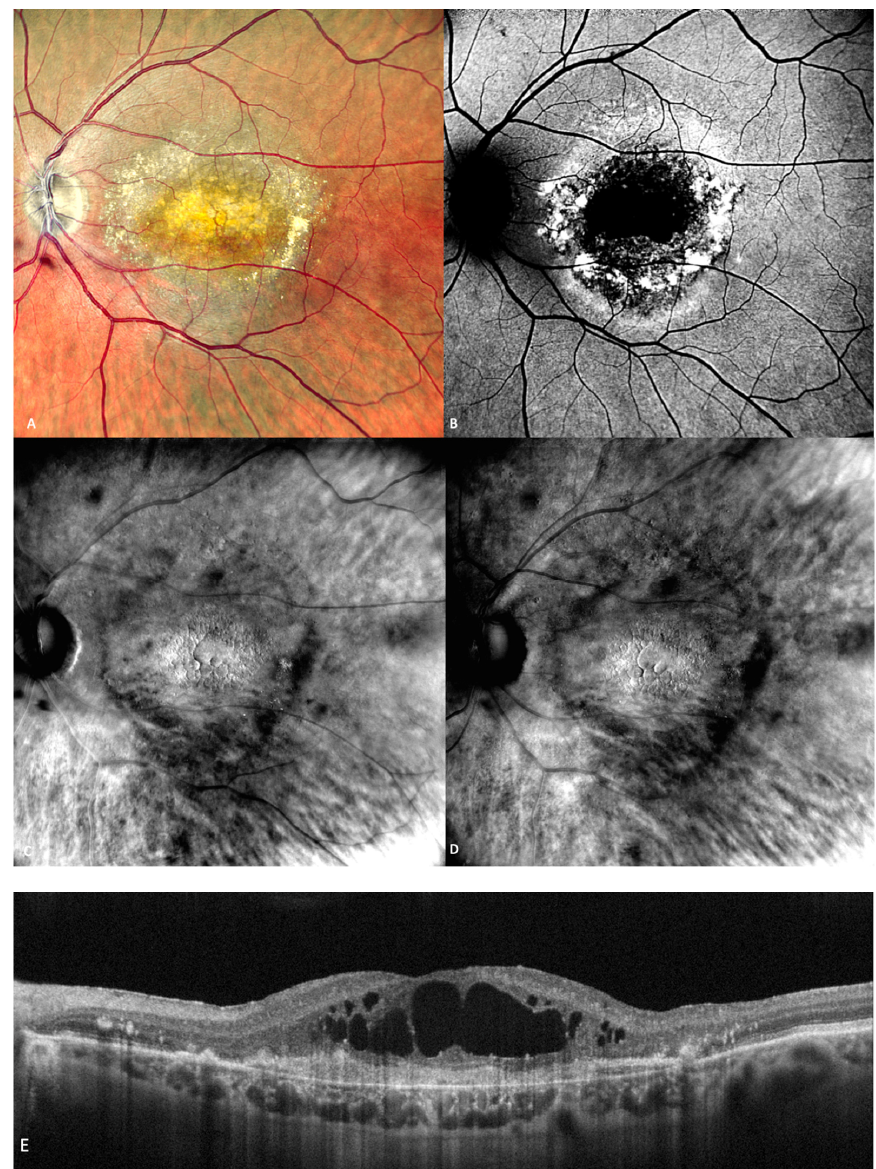
Figure 7. ( A ) The cSLO shows subfoveal fibrosis surrounded by exudates. ( B ) Mottled, irregular autofluorescence pattern with a central hypo-autofluorescent core. ( C ) Retromode DR and ( D ) Retromode DL images showing large, oval, concave, and, respectively, convex cystoid spaces. ( E ) Large intraretinal cystoid spaces seen over an area of subretinal fibrosis on SD-OCT. Based only on retromode imaging, it is hard to make a di ff erential diagnosis of dif- ferent macular diseases. However, retromode has also been proven to be a useful tech- nique in other macular conditions, such as diabetic macular edema [49,50], central serous chorioretinopathy [36,37], cystoid macular edema of diverse aetiology [48], retinal dystro- phies [51,52], myopic maculopathy [53,54], full-thickness macular holes [55] (Figure 8), epiretinal membranes [56] (Figure 9), and hydroxychloroquine retinopathy [57]. The